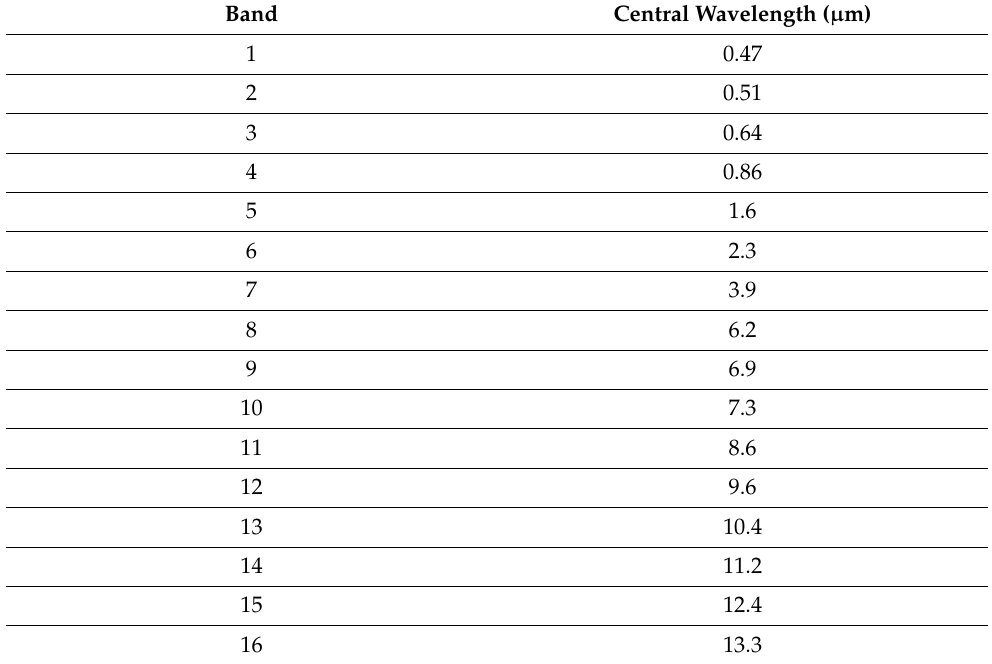
Table 1. Spectral Bands of Himawari-8/AHI. Band Central Wavelength ( µ